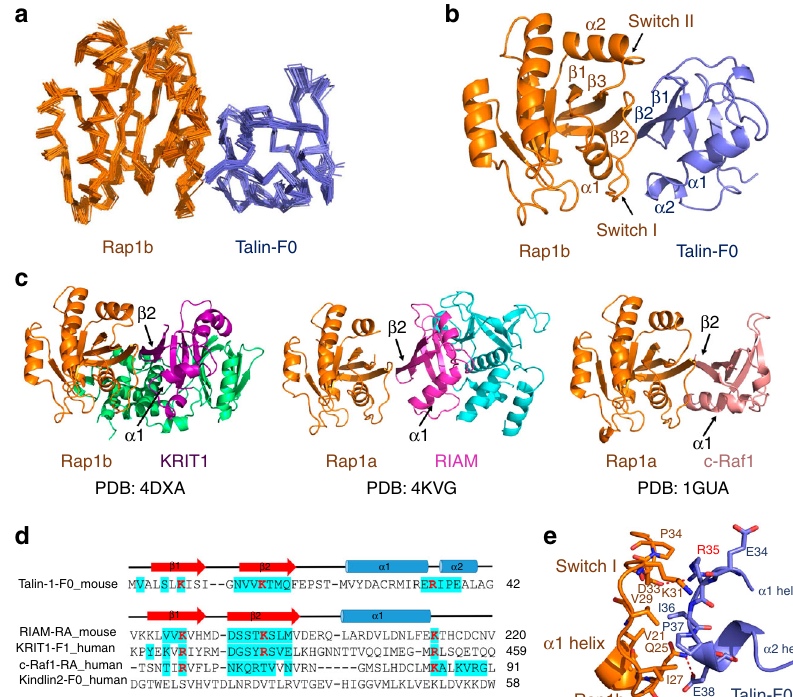
Fig. 4 Solution structure of Rap1b/talin-F0 complex by NMR. a Superposition of 20 calculated Rap1b/talin-F0 complex structures with lowest energies (shown in ribbon representation). b Cartoon representation of the Rap1b/talin-F0 complex structure with the lowest energy. c Current solved complex structures of Rap1 and its effector proteins (shown in cartoon representation). d Structure-based sequence alignment of talin-F0 and RA domain containing Rap1b effector proteins or kindlin2-F0 (only binding interfaces were shown). Residues involved in the binding interface with a cutoff of 4 Å are highlighted in cyan. Conserved residues are colored in red. e Detailed interaction diagram between the α 1 helix and switch I of Rap1b and the α 2 helix of talin-F0. Hydrogen bond or salt bridge is represented by red dashed